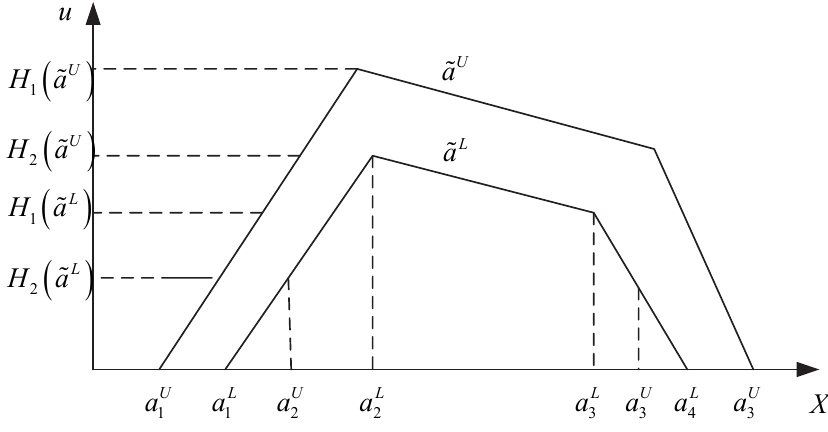
Fig. 1. A trapezoidal interval type-2 fuzzy sets (Ghorabaee et al.,